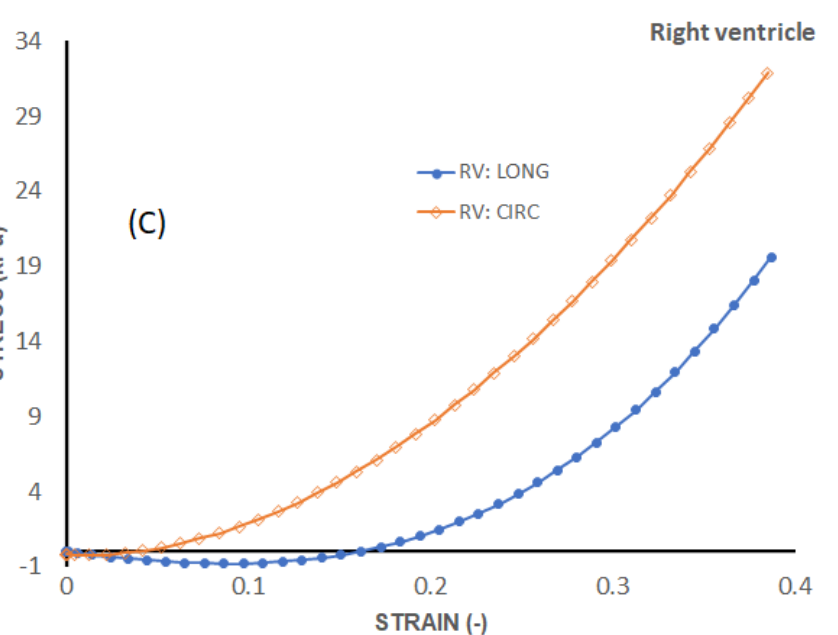
Figure 7. Longitudinal vs circumferential stress–strain curves for each heart wall’s myocardium. ( a ) Average stress–strain curves of LV, ( b ) Average stress–strain curves of Septum and ( c ) Average stress–strain curves of RV.